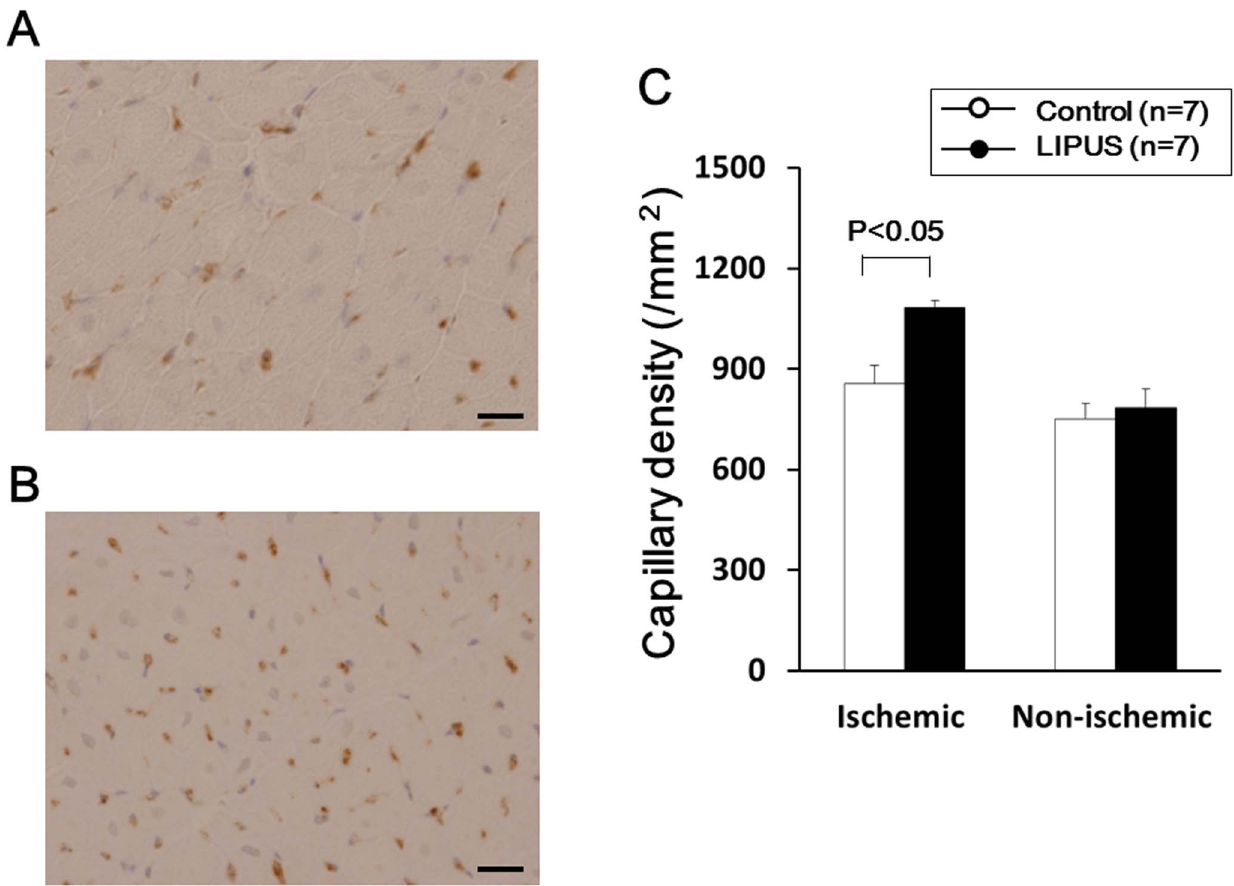
Figure 5. LIPUS therapy increased the density of factor VIII-positive capillaries in the ischemic myocardium. ( A, B ) Factor VIII staining of the LCx region from the control ( A ) and the LIPUS group ( B ). Scale bar represents 20 m m. C. Capillary density was significantly higher in the LIPUS group than in the control group in the ischemic lateral wall. Results are expressed as mean 6 SEM (n=7 each).